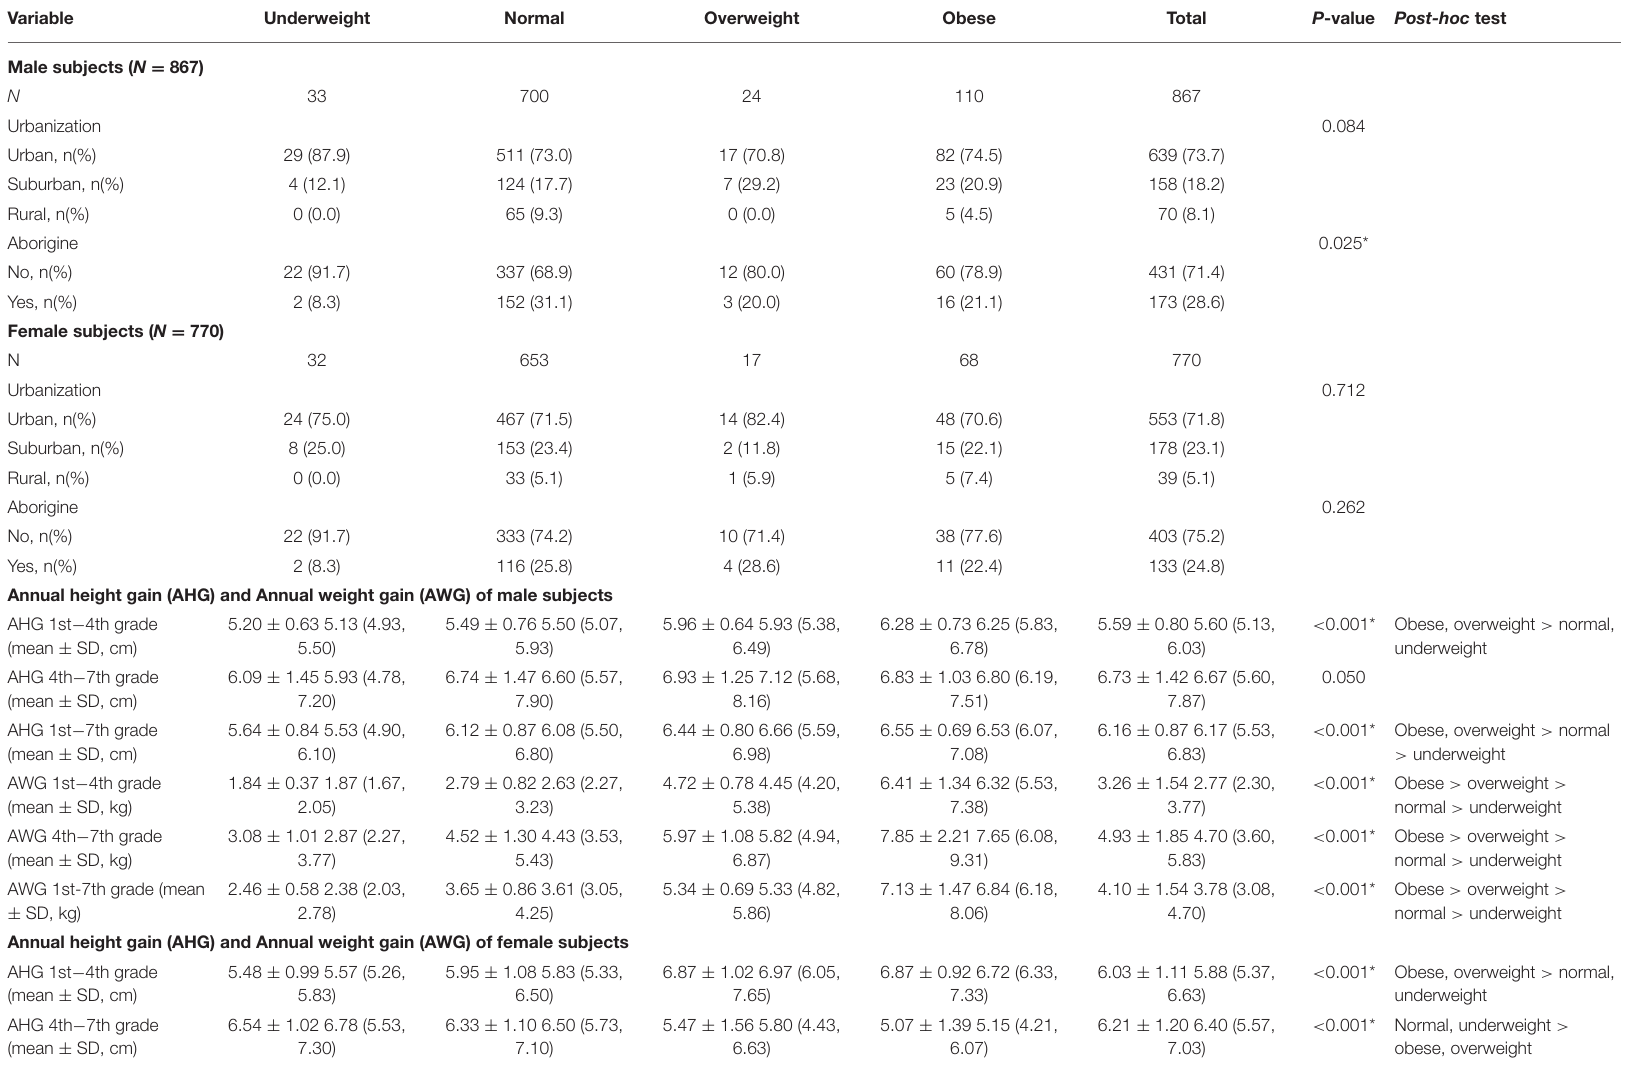
TABLE 1 | Demographics among BMI groups (2009–2015) ( N =